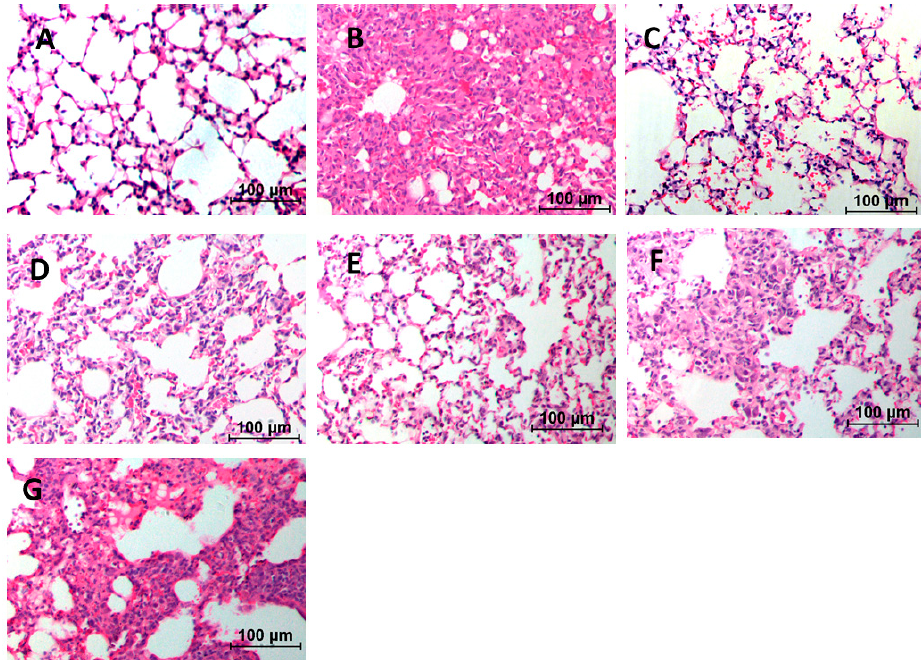
Figure 1. Effect of m KG on histopathologic changes in BLM-induced pulmonary fibrosis mice. ( A ) Normal group; ( B ) BLM group; ( C ) Pirfenidone group; ( D ) Dexamethasone group; ( E ) m KG-H group; ( F ) m KG-M group; ( G ) m KG-L group. All sections were stained with HE and representative sections are shown at the same magnification (200×).